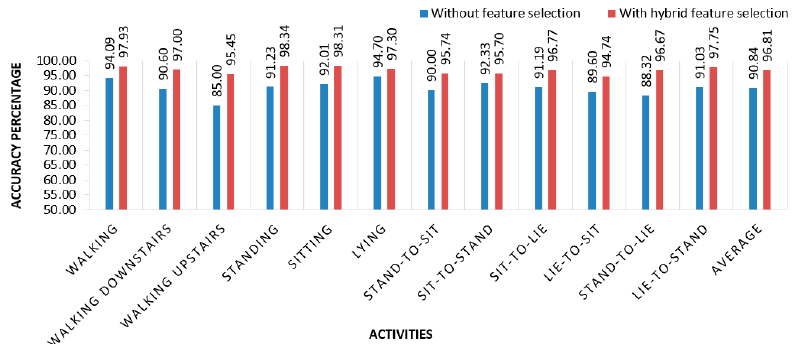
Table 6. Classification accuracies of different feature selection algorithms.